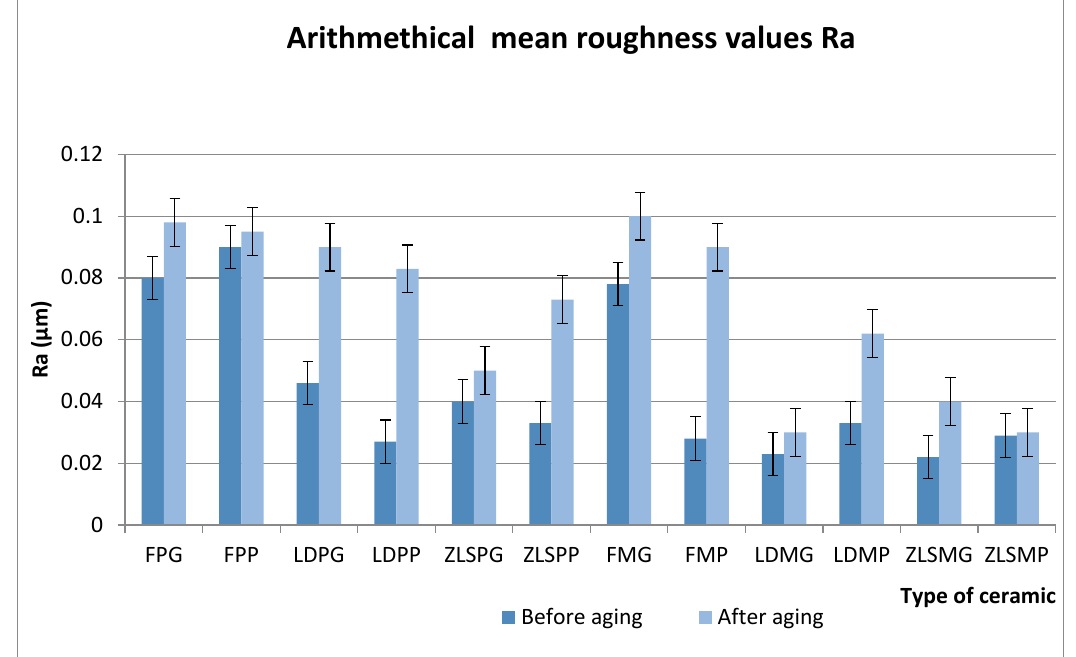
Figure 3. Mean values for Ra parameter before and after thermocycling for the hot-pressed and milled ceramics.